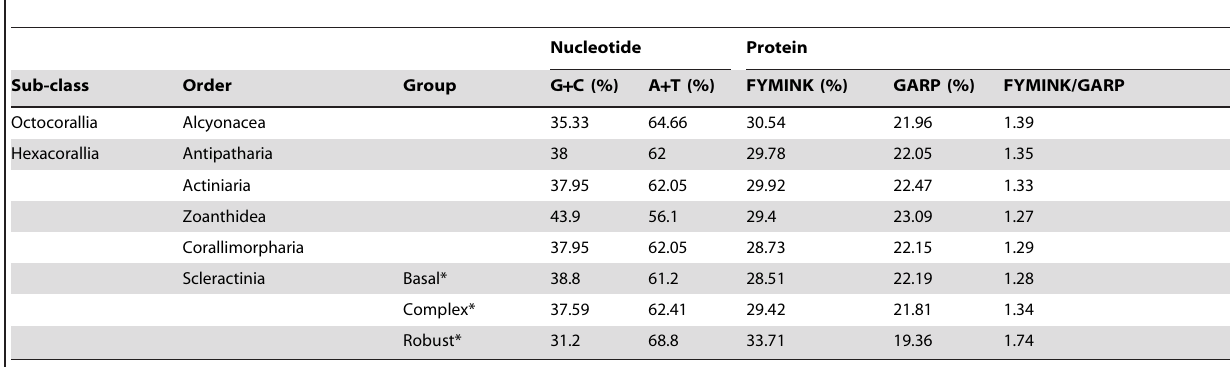
Table 2. Compositional biases of the mitochondrial genomes of the anthozoan Orders included in the present